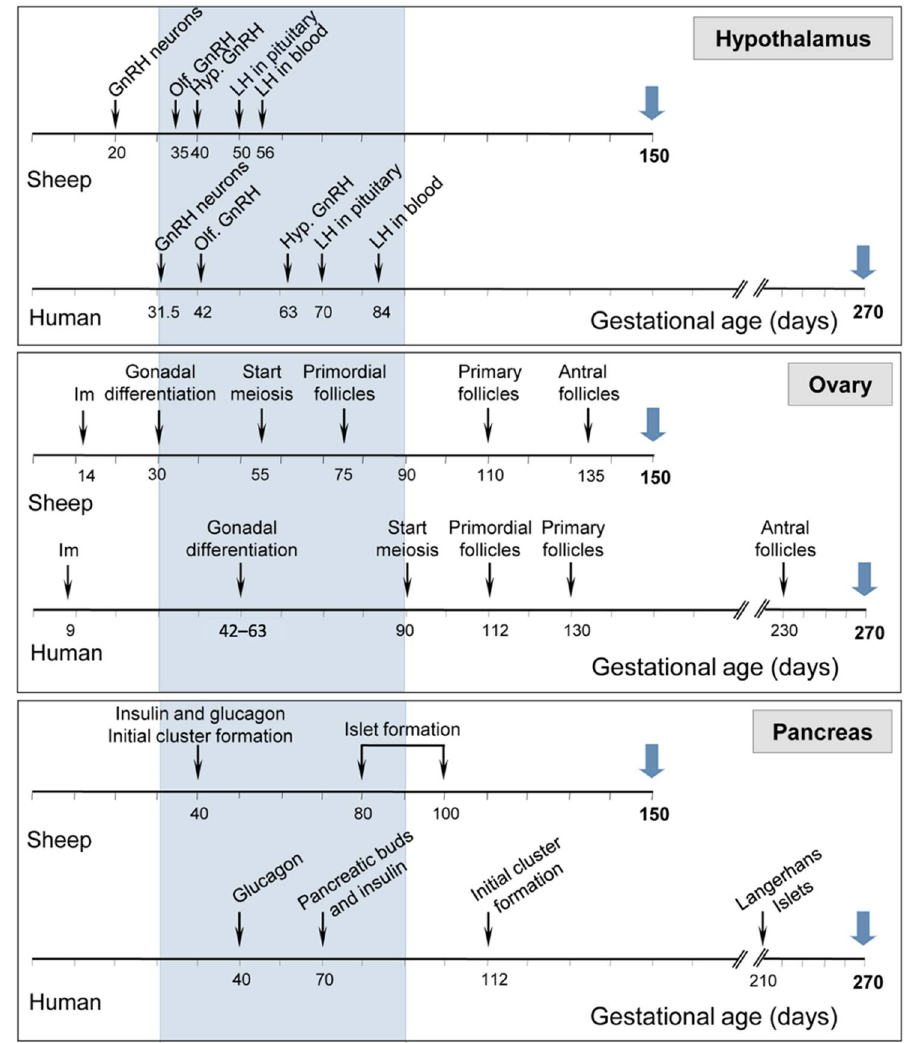
Figure 2. Comparison in sheep and humans of the timing of development of neural circuitry in the hypothalamus ( top panel), follicular differentiation in the ovary ( middle panel), and secreting cells in the pancreas ( bottom panel). Blue arrows indicate gestational length. Hypothalamus: gonadotrophin-releasing hormone (GnRH) neurons: appearance of first GnRH immunoreactive neurons, Olf. GnRH: GnRH neurons visible in olfactory bulb, and Hyp. GnRH: appearance of GnRH neurons in the hypothalamus. Ovary: Im: implantation. Figure adapted from sheep models of polycystic ovary syndrome phenotype by Padmanabhan et al. [84] with permission from Elsevier.